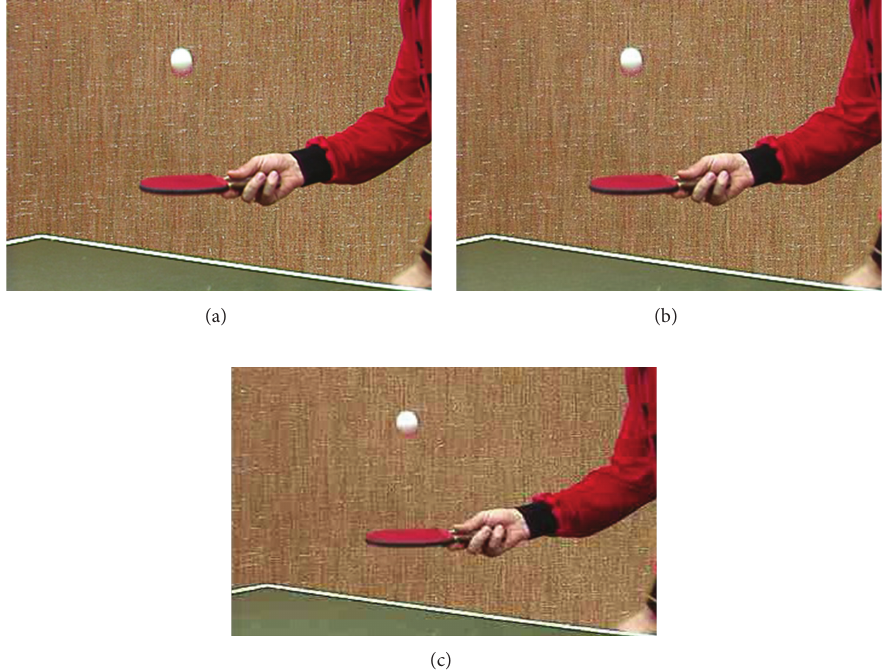
Figure 6: (a) Frame 2 in the proposed method, (b) Frame 2 in F-transforms, and (c) Frame 2 in MPEG-4.